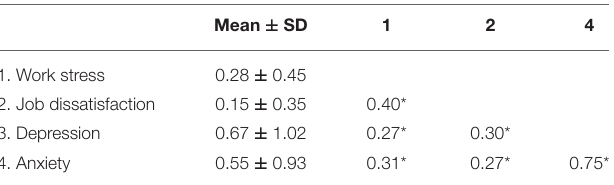
TABLE 3 | Pearson’s